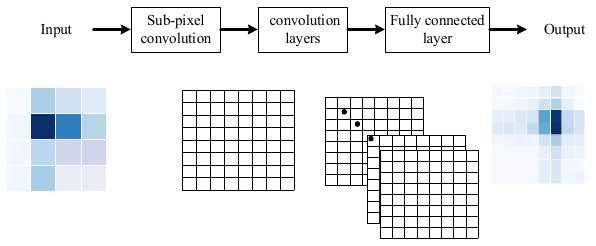
Figure 4. The estimated model of this paper. Table 2. Architecture of the estimation model.